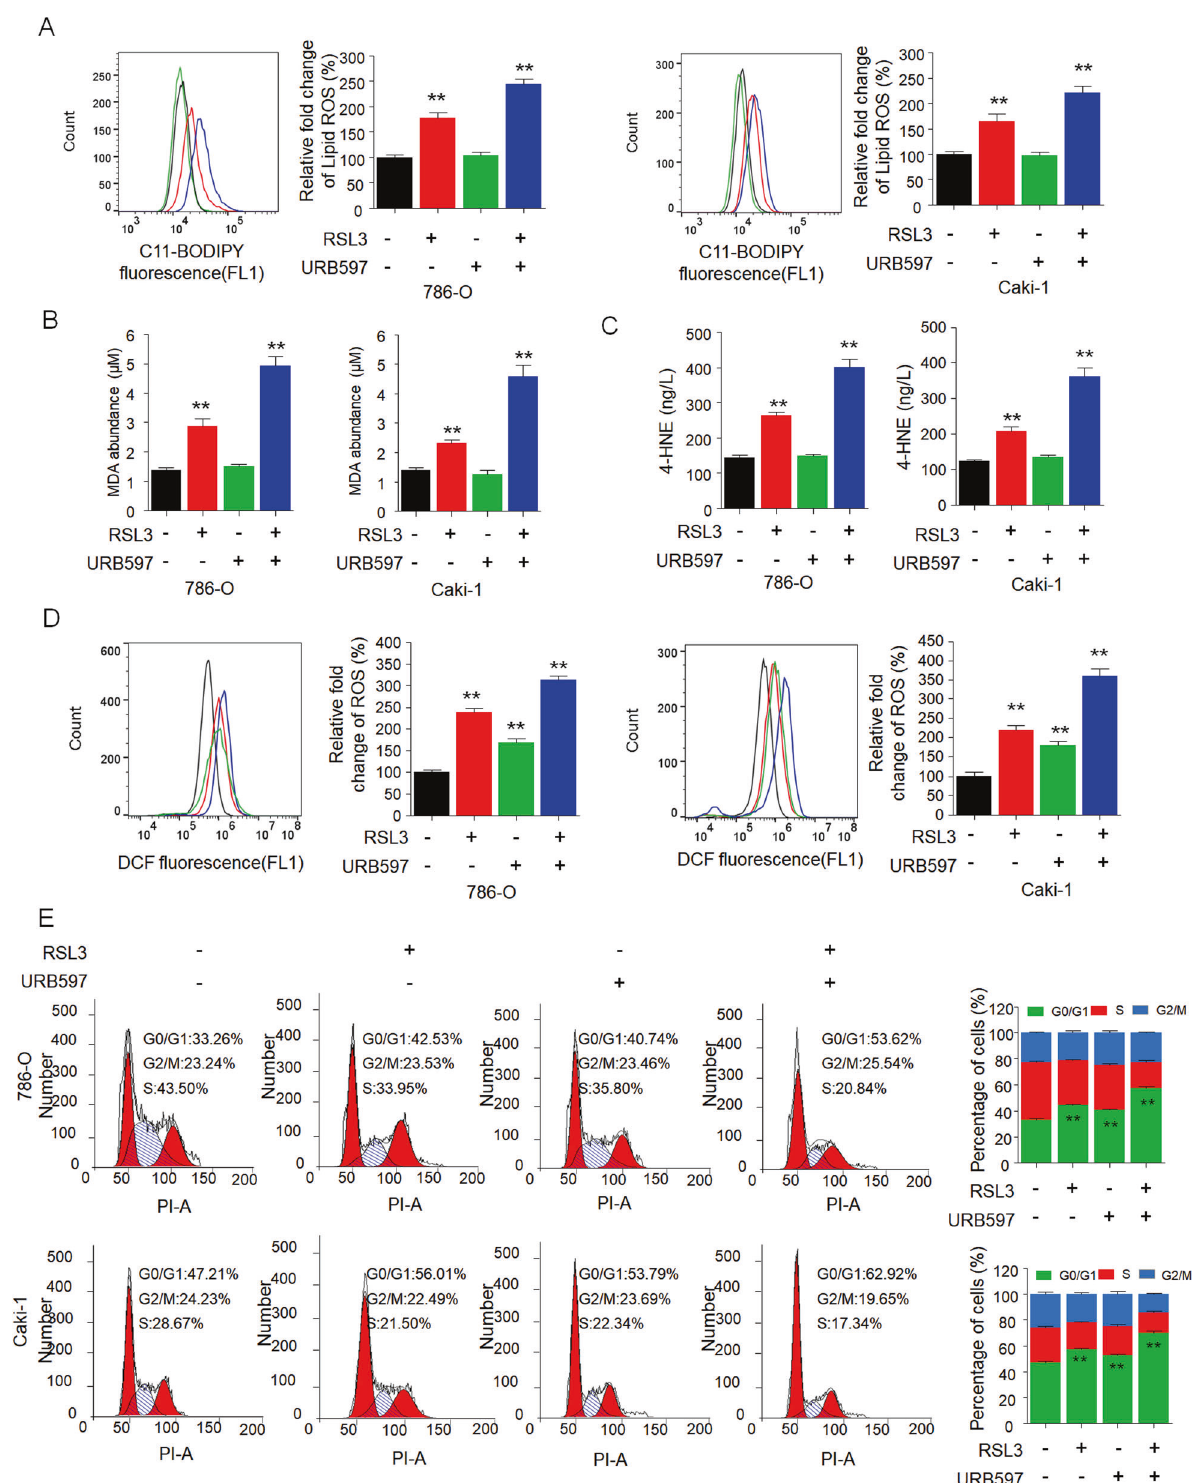
Fig. 3 URB597 combined with RSL3 signi fi cantly inhibits the growth of RCC cells by inducing ferroptosis and cell cycle arrest. Level of lipid peroxidation ( A ), MDA ( B ), 4-HNE ( C ), and cytosolic ROS production ( D ) in 786-O and Caki-1 cells treated with URB597 (10 µM) and RSL3 (0.5 µM) singly or in combination for 48 h. Lipid peroxidation and cytosolic ROS were assessed by fl ow cytometry with C11-BODIPY and H 2 DCFDA, respectively. Histograms show the production of MDA, the production of 4-HNE, and the relative fold change in lipid ROS and cytosolic ROS (right panel). E Cell cycle distributions of 786-O and Caki-1 cells treated as in ( A ). The cell cycle was evaluated by fl ow cytometry after staining with propidium iodide (PI). Histograms show the cell cycle distributions of treated 786-O and Caki-1 cells (right). Data are means ± SDs of measurements repeated three times with similar results. ** p < 0.01 versus the corresponding control ( t test).